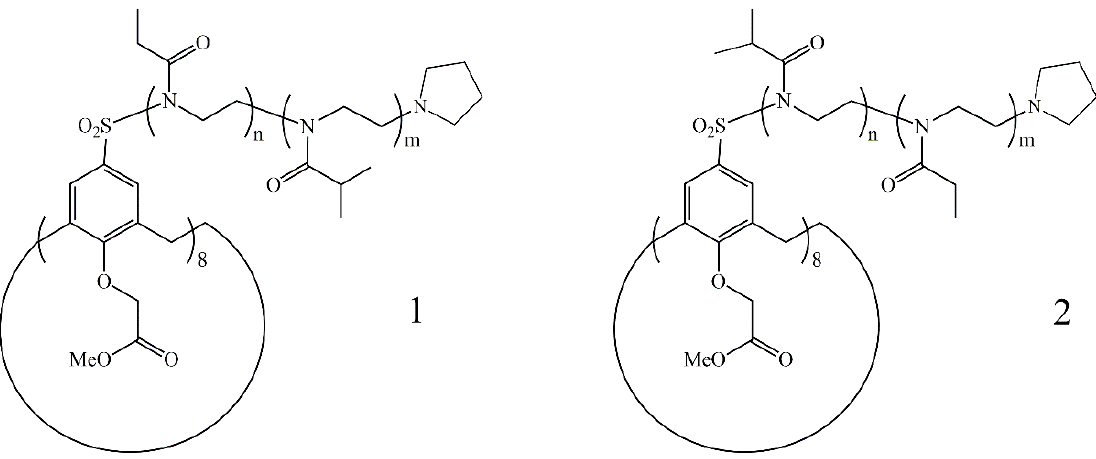
Figure 4. Structures of obtained star-shaped block-copolymers C8A-(PEtOx-b-PiPrOx) ( 1 ) and C8A-(PiPrOx-b-PEtOx) ( 2 ). In order to obtain the statistical copolymer, equivalent amounts of 2-ethyl-2-oxazoline and 2-isopropyl-2-oxazoline were mixed in the polymerization vial. The proposed method of synthesis consisted of the simultaneous copolymerization of both monomers. It was found that the relative reactivity of EtOx and iPrOx in simultaneous copolymerization are equal to 0.79 and 1.78, respectively [48]. It can be assumed that the structure of the statistical copolymer formed in the reaction mixture would be the gradient most probably. Figure 5 shows the structures of C8A-P(EtOx-grad-iPrOx) and star-shaped homopolymer C8A-PEtOx.